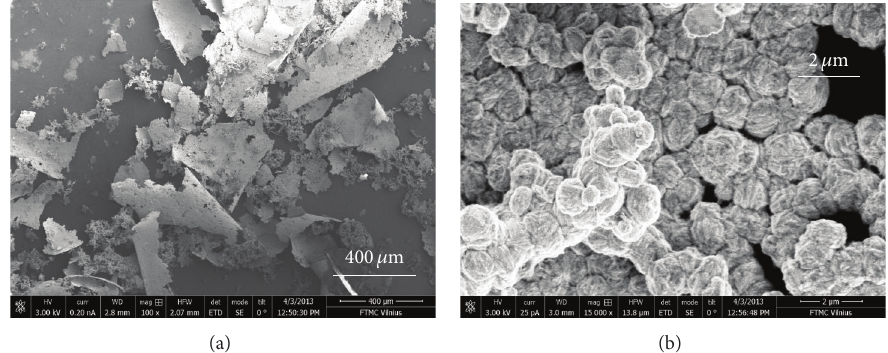
Figure 2: SEM views of Co-Ru alloy product formed in an aqueous solution of 0.04 CoCl 2 , 0.004 RuCl 3 , 0.08 sodium citrate, 0.33 NaOH, and 1.7mol/L hydrazine hydrate at ambient pressure and 40 ∘ C for